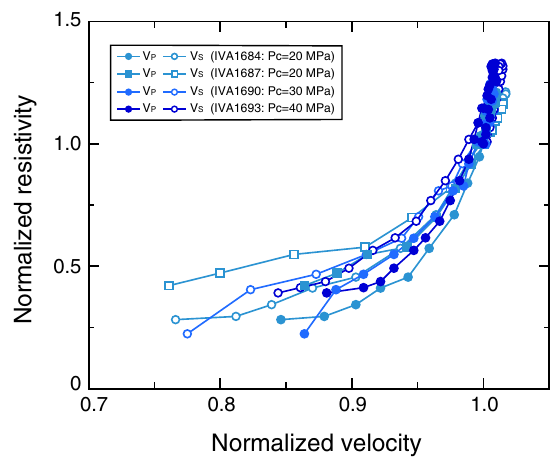
Fig. 6 Relationship between the electrical resistivity and elastic wave velocities during the deformation experiments, with both measurements normalized to their initial values prior to